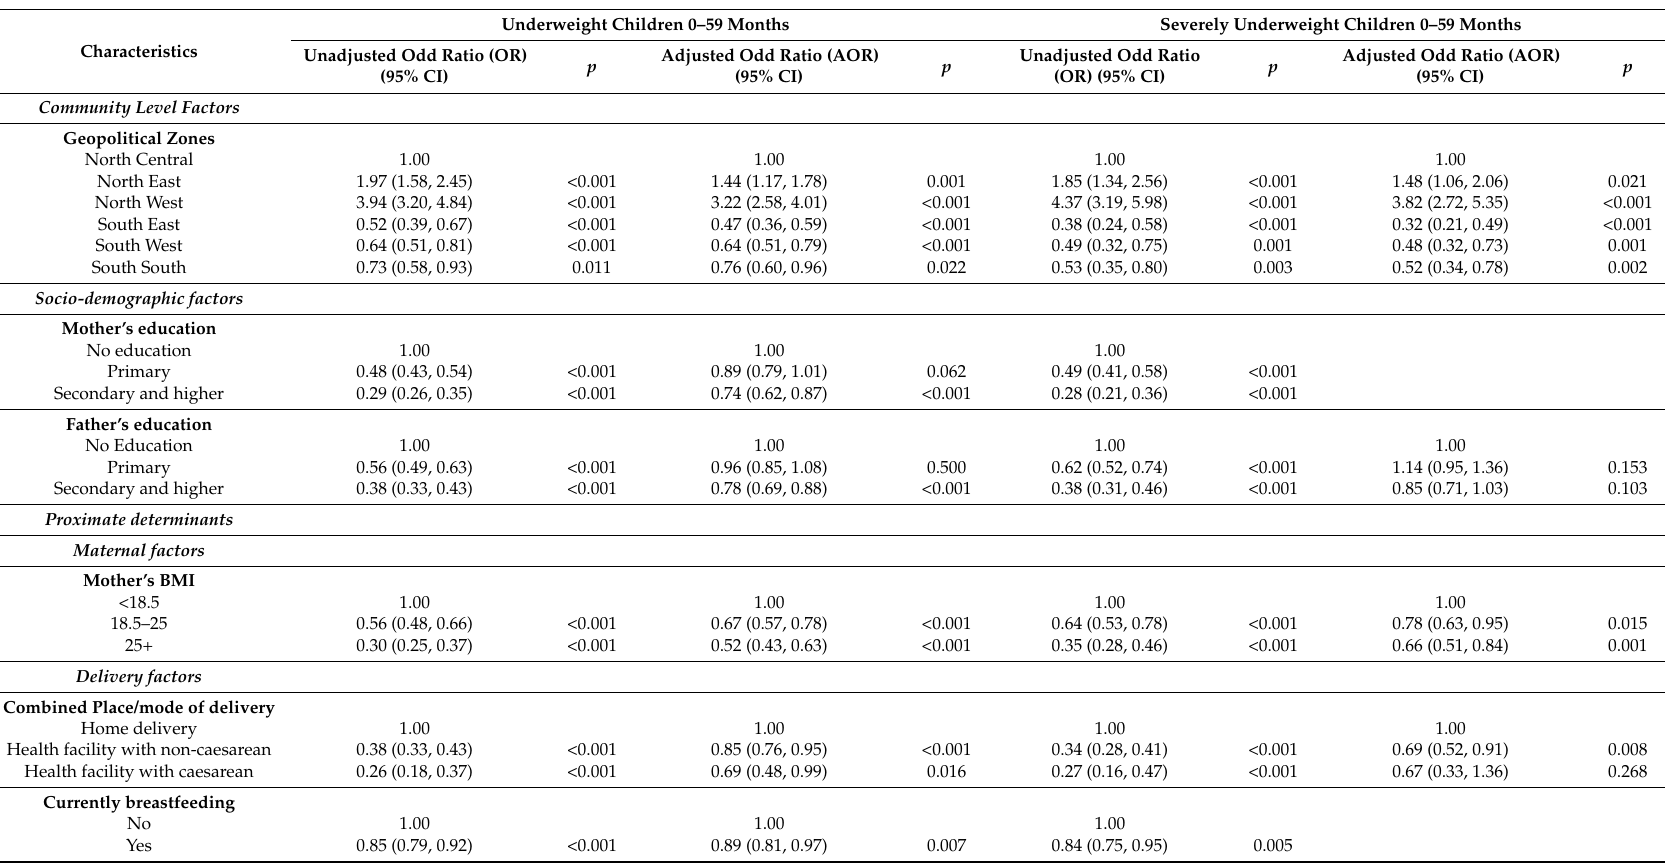
Table 3. Unadjusted and adjusted odds ratios (OR) (95% CI) for underweight and severely underweight children aged 0–59 months.